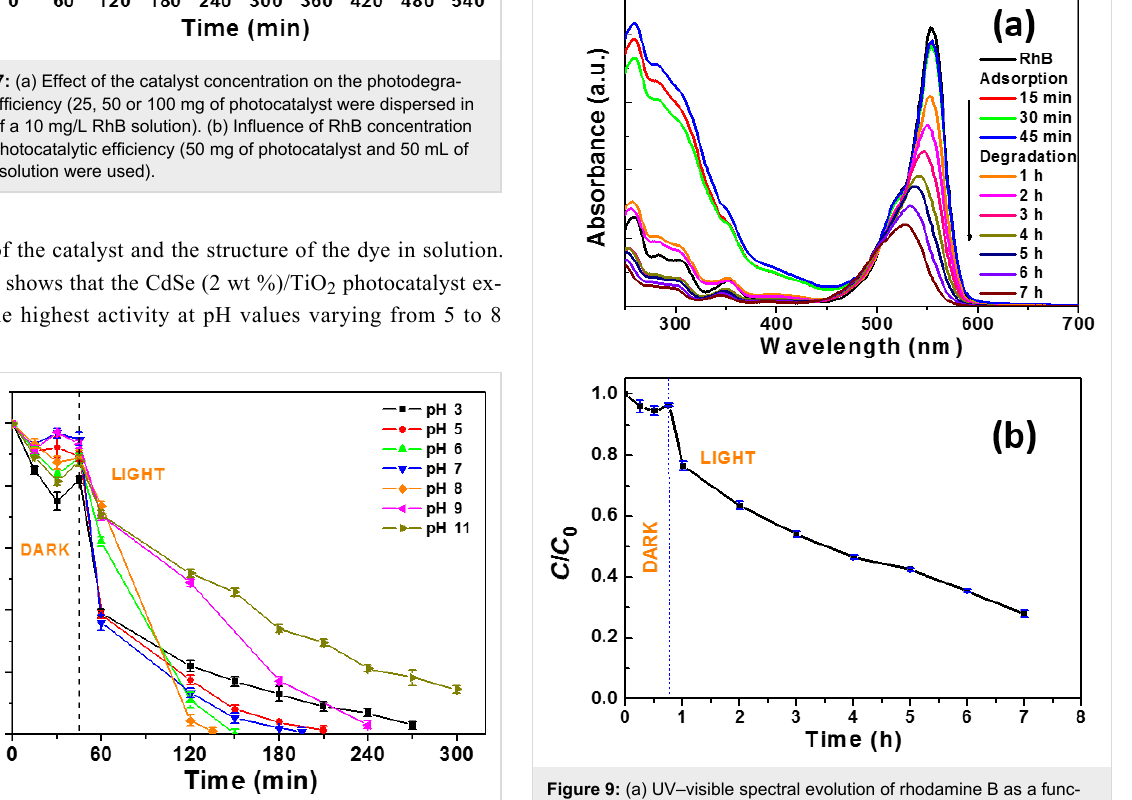
Figure 8: Influence of pH on the degradation of rhodamine B using the CdSe (2 wt %)/TiO 2 photocatalyst.